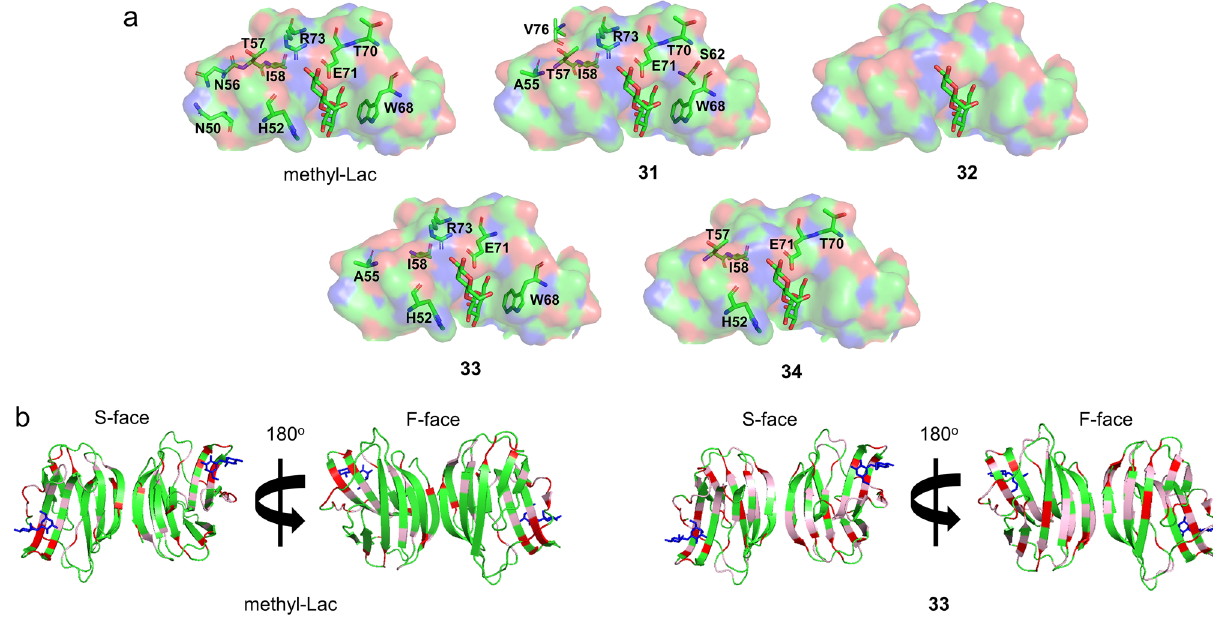
Figure 7. S-face focused electrostatic map of Gal-1 monomer (PDB access code: 1GZW) with the most perturbed amino acid residues by methyl-Lac, glyco-amino acid 31 , peptide 32 , LacNAc-terminated glycopeptide 33, and sialyl-LacNAc-terminated glycopeptide 34 ( a ). The crystal structure of Gal-1 (PDB access code: 1GZW) is shown with the largest Δδ values highlighted in red (Δδ ≥ 0.05) and pink (0.025 ≥ Δδ < 0.05) for methyl-Lac ( C ) and compound 33 ( b ). For orientation, lactose is presented in all